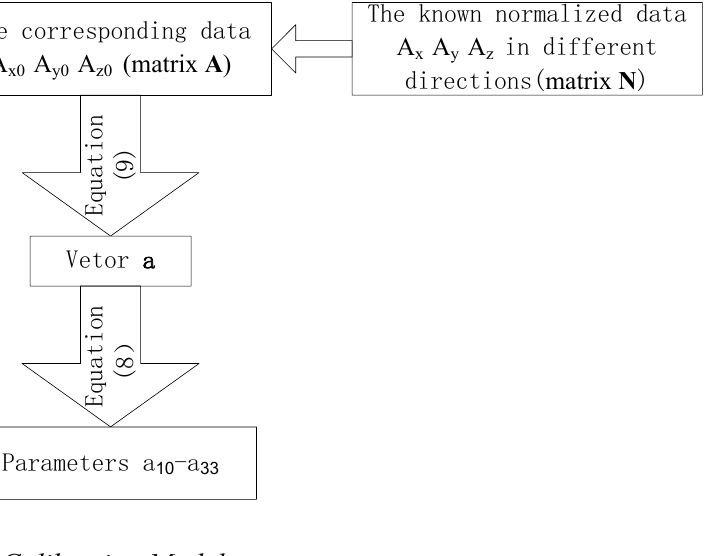
Figure 6. The calculation process of accelerometer calibration parameter. The corresponding data A x0 A y0 A z0 (matrix A